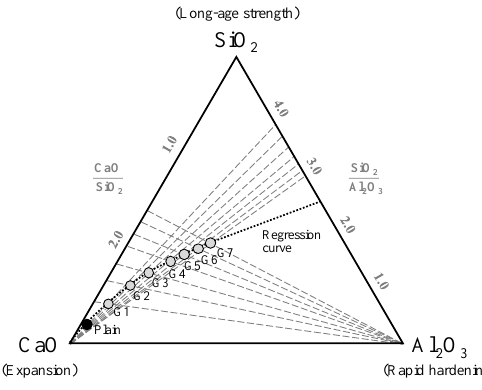
Figure 9. CaO / SO 3 and SO 3 / Al 2 O 3 molar ratios based on the replacement ratio. Figure 9. CaO/SO 3 and SO 3 /Al 2 O 3 molar ratios based on the replacement ratio.